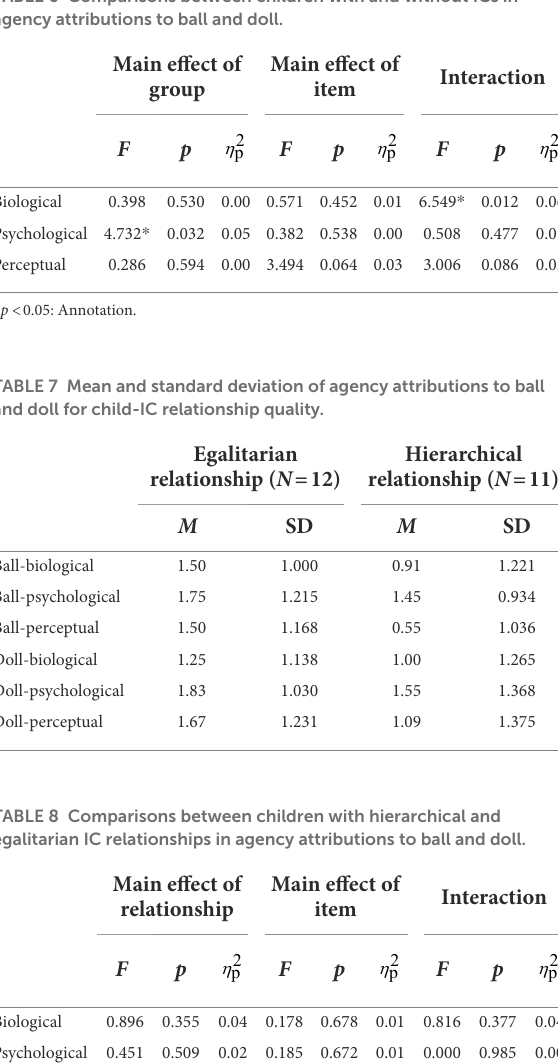
TABLE 6 Comparisons between children with and without ICs in agency attributions to ball and doll.